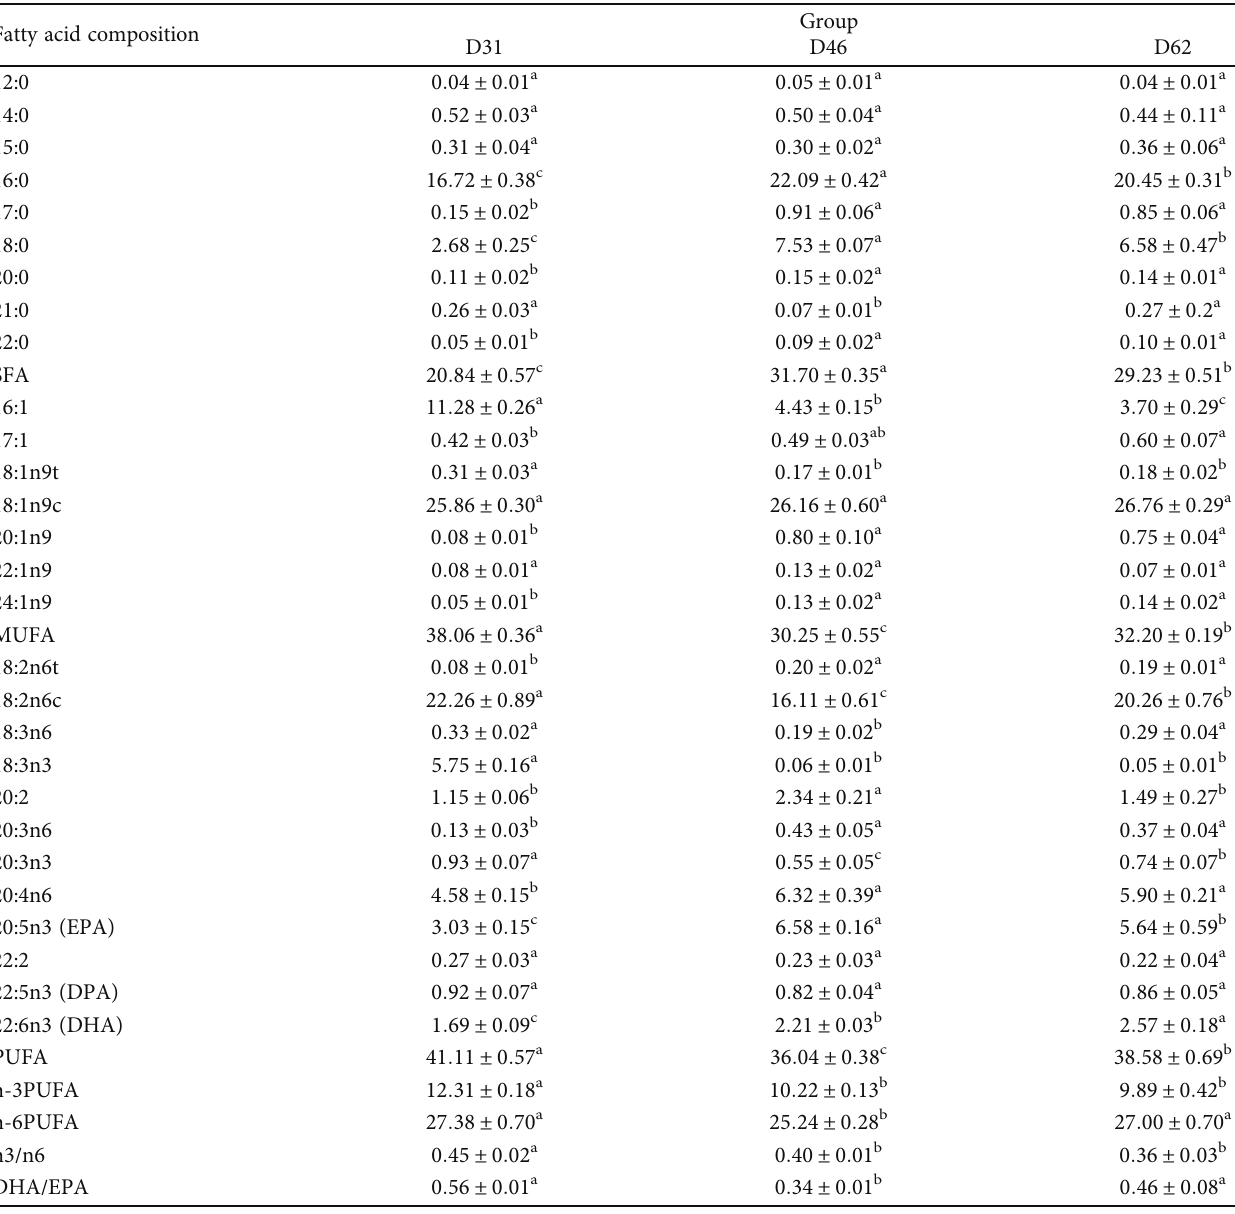
Table 9: Fatty acid composition of female E. sinensis ovary in rice-crab coculture system at di ff erent developmental periods (% dry weight). Group Fatty acid composition D31 D46